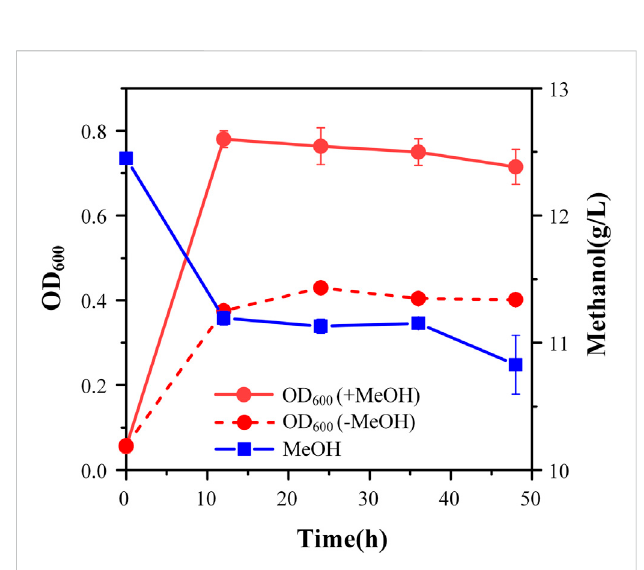
Cell growth and methanol consumption of strain Ev17. Error bars represent standard deviation, n =